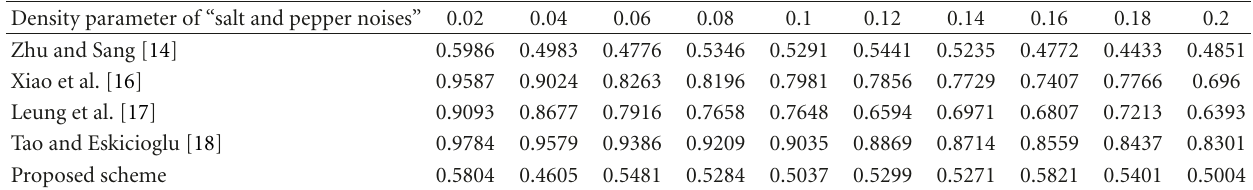
Table 3: Experiment results comparison under salt and pepper noises (NC values).